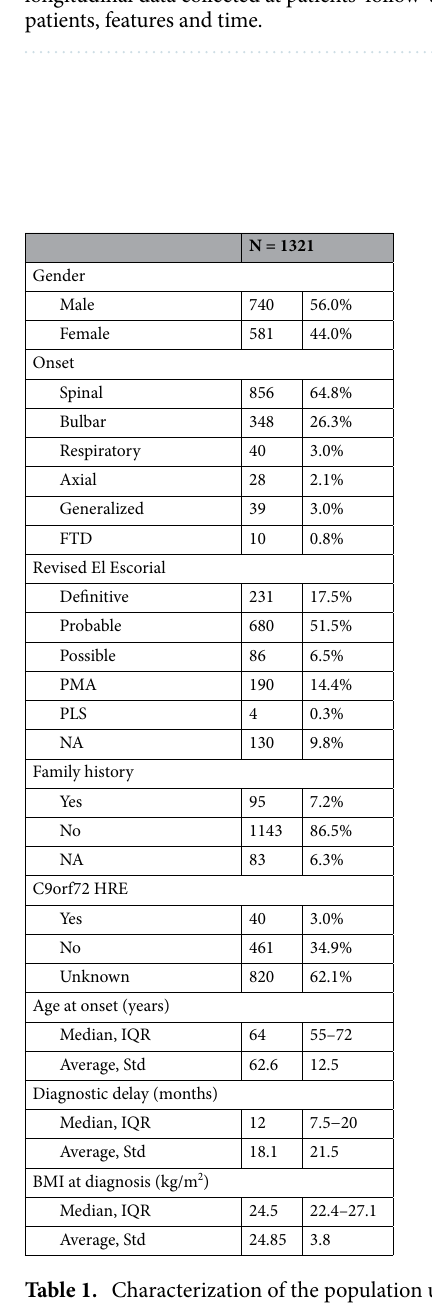
Table 1. Characterization of the population used in the case study.